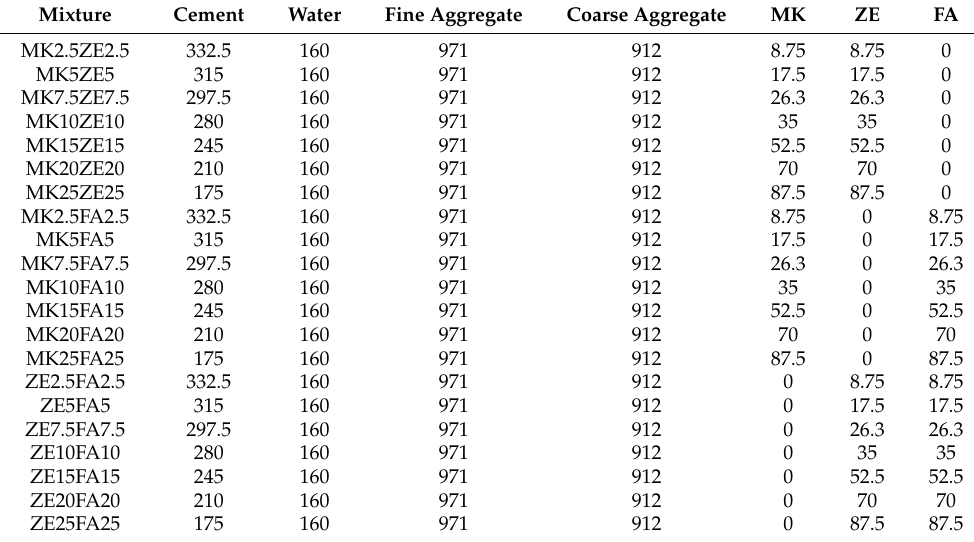
Table 6. Details of mix proportions [All unites are in kg/m 3